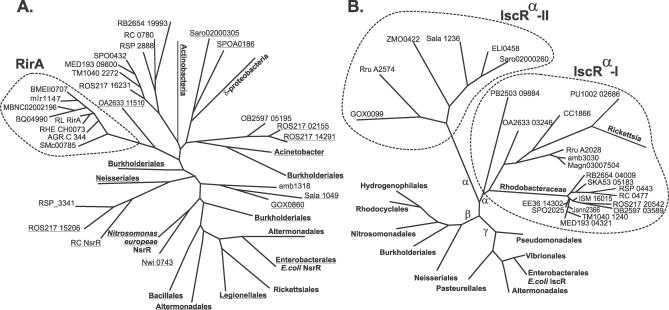
Phylogenetic Tree of the α-proteobacterial Regulators from the Rrf2 Superfamily(A) RirA/NsrR, (B) IscR. Genome abbreviations are listed in Figure 1. nsrR/rirA homologs positionally linked with the nitrosative stress response genes are underlined.